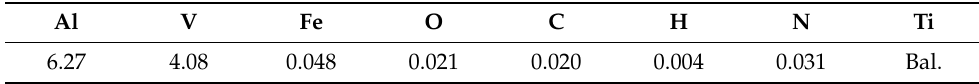
Table 1. Chemical composition of TC4 titanium alloy (wt%).